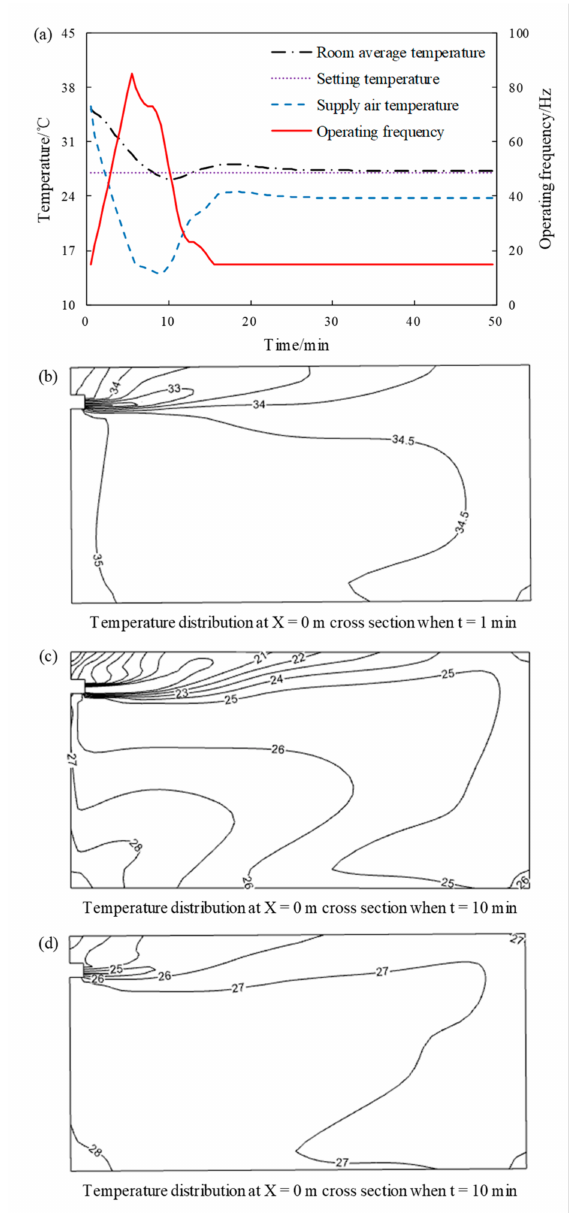
Figure 8. Change process of the room local temperature: ( a ) Variations of the main dynamic parame- ters with time; ( b – d ) Temperature distribution of profile X = 0 m at different